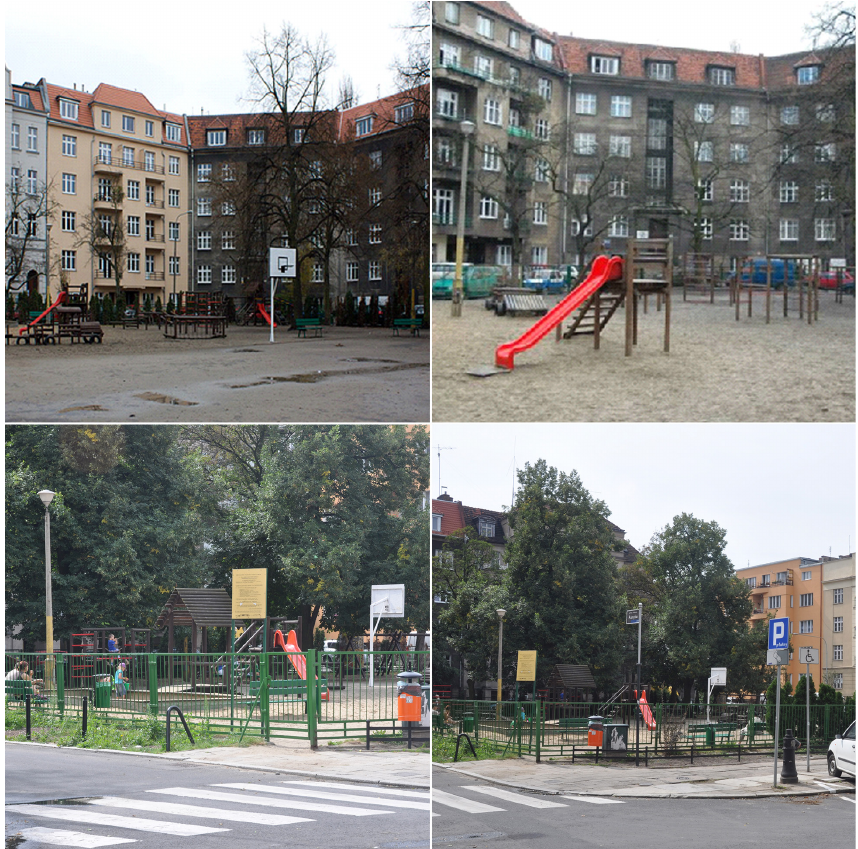
Fig. 1. Asnyk Square before